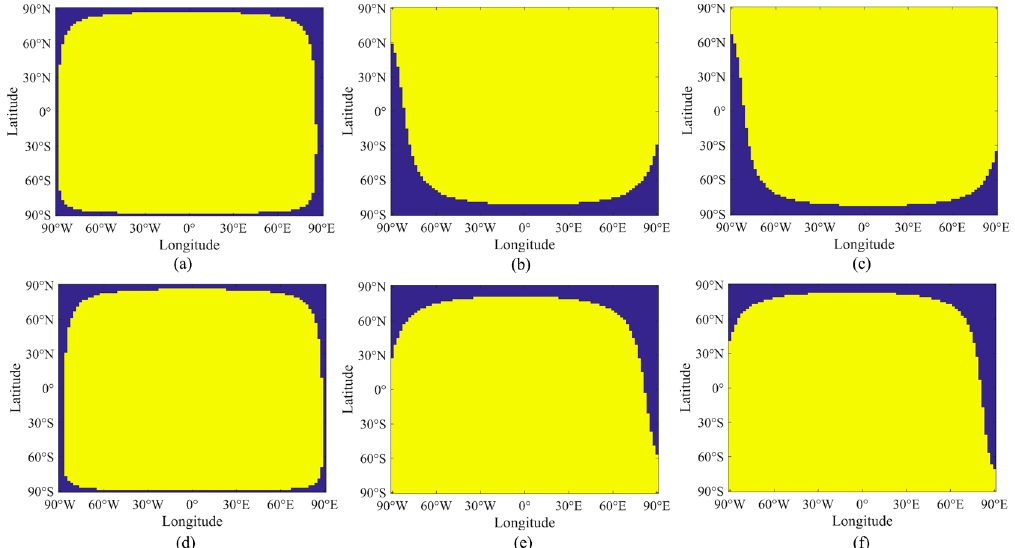
Figure 11. The area on the Moon where sensor equipped on can observe hemisphere of the Earth at 00:00 UTC on ( a ) 1, ( b ) 6, ( c ) 11, ( d ) 16, ( e ) 21, and ( f ) 26 January 2010.